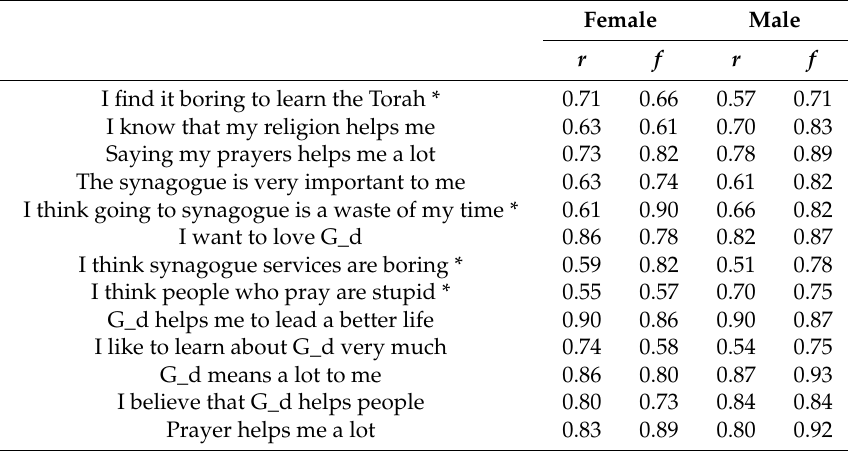
Table 1. The Katz-Francis scale of attitude toward